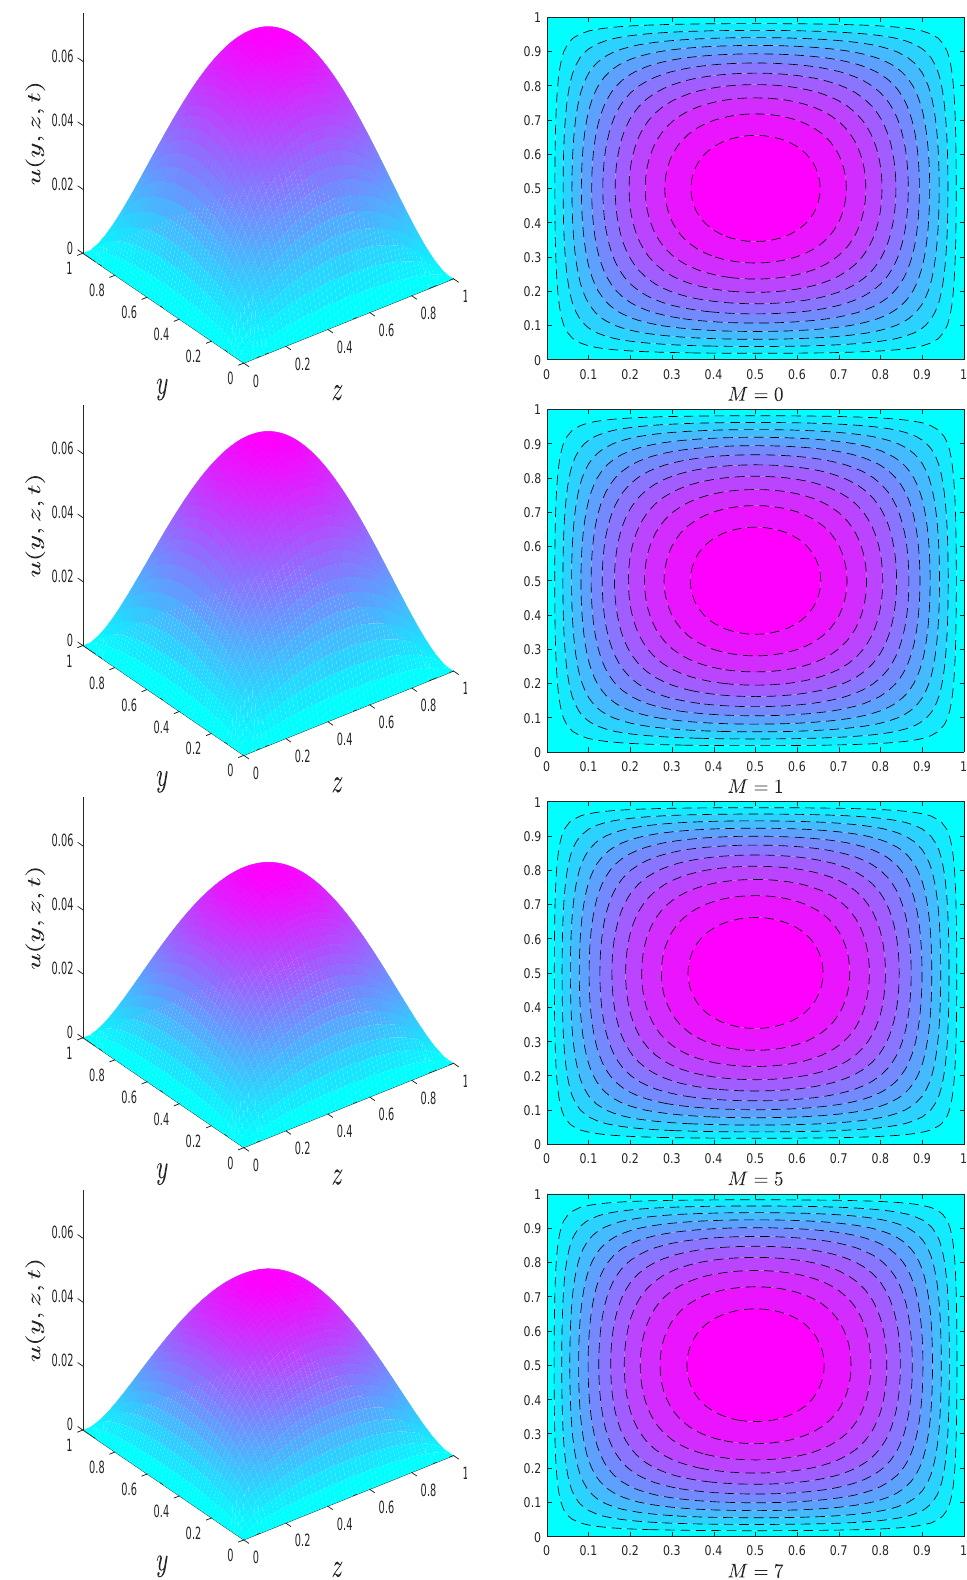
Figure 3. Velocity profile for different values of magnetic parameter M